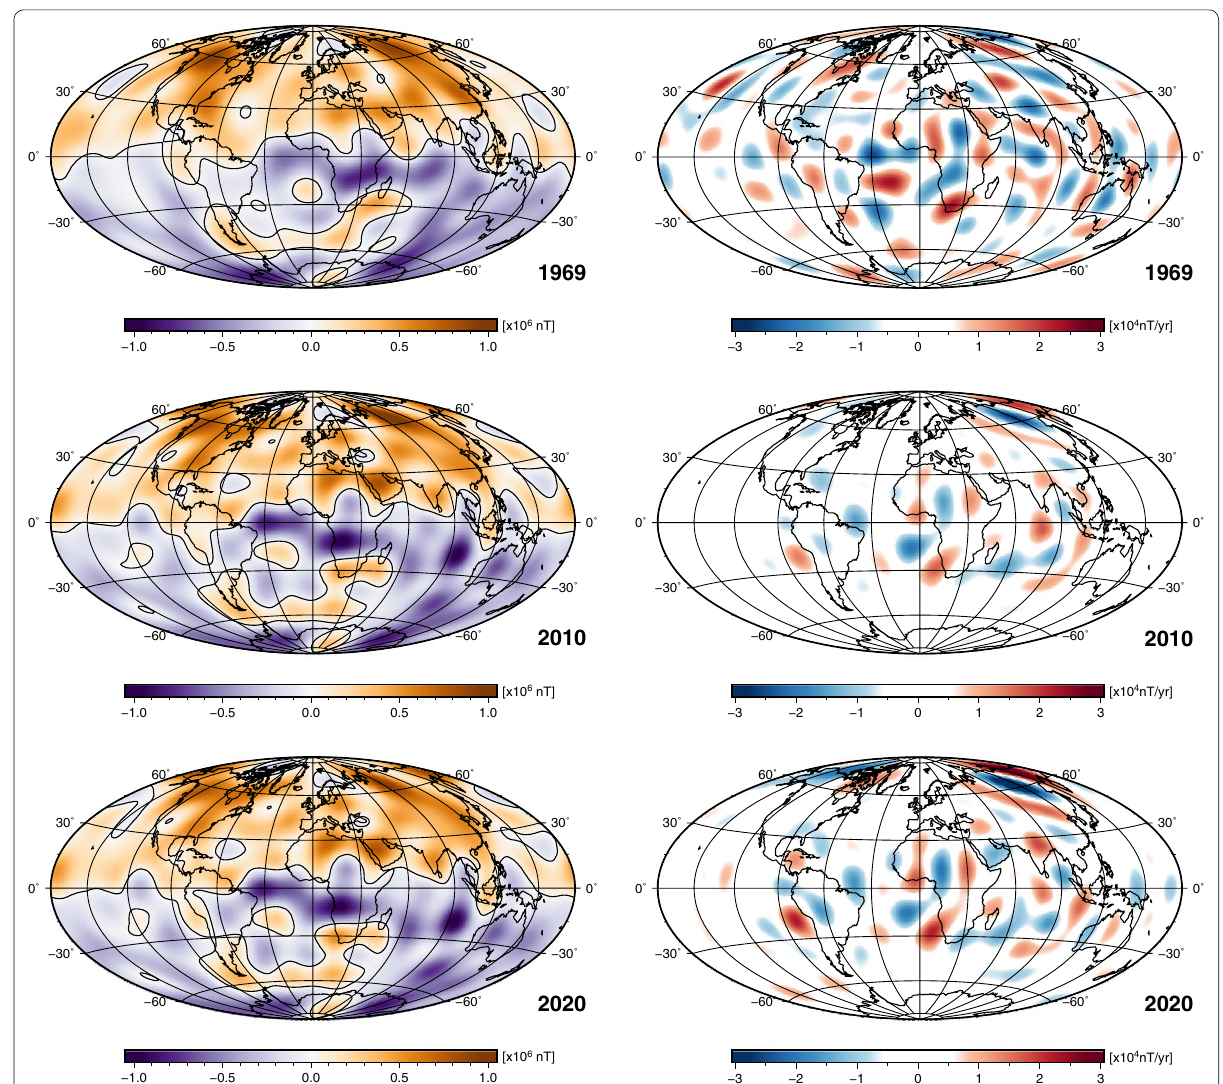
Fig. 6 Radial component of the magnetic field at the core surface (left) and its secular variation (right) derived from Model 1 for epochs 1969, 2010 and